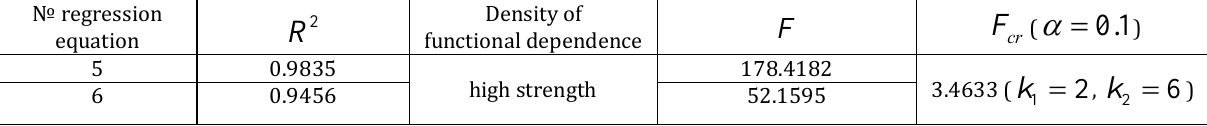
Table 3. Analysis of the adequacy of the proposed mathematical models № regression 2 R Density equation